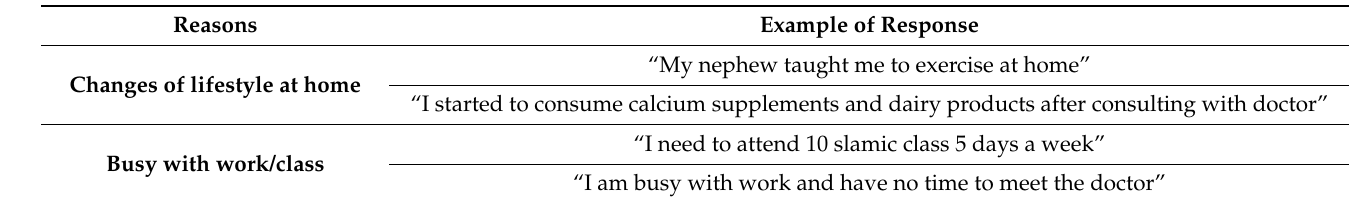
Table 5. Examples of written feedback from the subjects for not meeting medical doctors for fur- ther